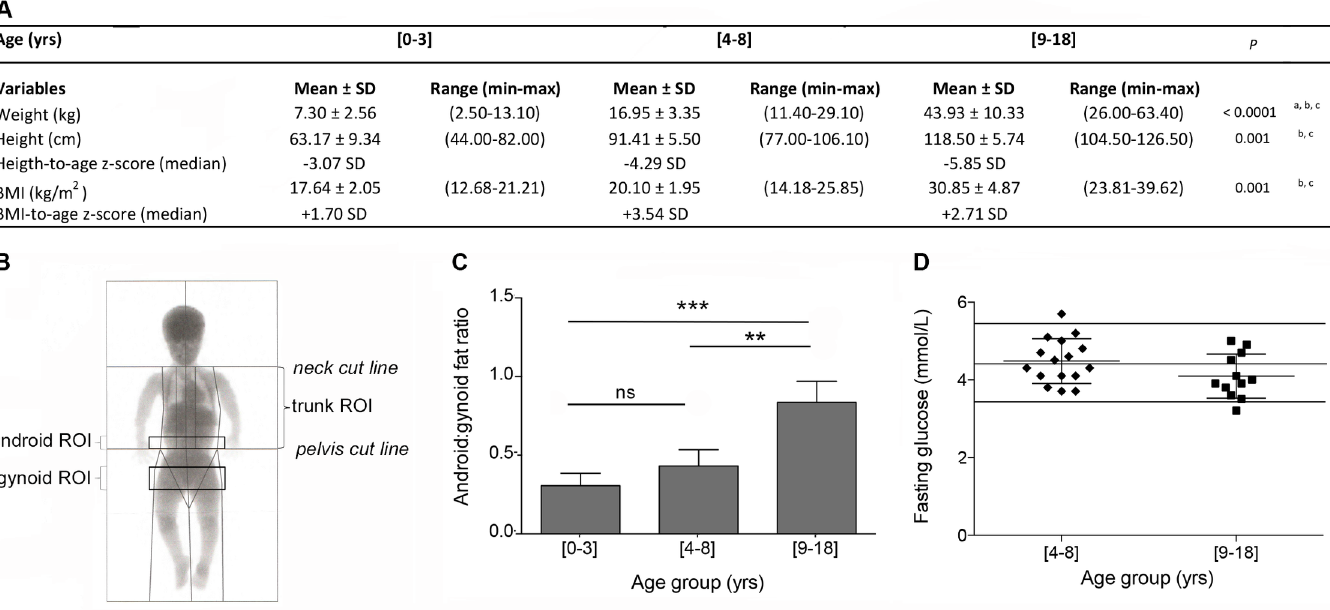
Fig 1. Children with achondroplasia preferentially develop abdominal obesity without an increase in blood glucose levels. ( A ),Weight, height and BMI measurements and corresponding height-to-age and BMI-to-age z-scores in the three age groups ranging (n = 73 data points in the [0–3] years old group, n = 61 data points in the [4–8] years old group and n = 36 data points in the [9–18] years old group). ( B ),Schematic representation of the different regions of interest (ROI) evaluated by DXA. ( C ), Android:gynoid fat ratio measurement in the three age groups ranging (n = 4 data points in the [0–3] years old group, n = 6 data points in the [4–8] years old group and n = 9 data points in the [9–18] years old group). ( D ),Plasmatic fasting glucose concentration in the two age groups ranging [4–8] and [9–18] years old (n = 16 data points in the [4–8] years old group and n = 12 data points in the [9–18] years old group). Horizontal lines represent normal values. Data are represented as mean ± SD, (cid:3)(cid:3) p < 0.01, (cid:3)(cid:3)(cid:3) p < 0.001.Results of post hoc analyses: a significantly different between [0–3] and [4–8] groups; b significantly different between [0–3] and [9–18] groups; c significantly different between [4–8] and [9–18] groups.